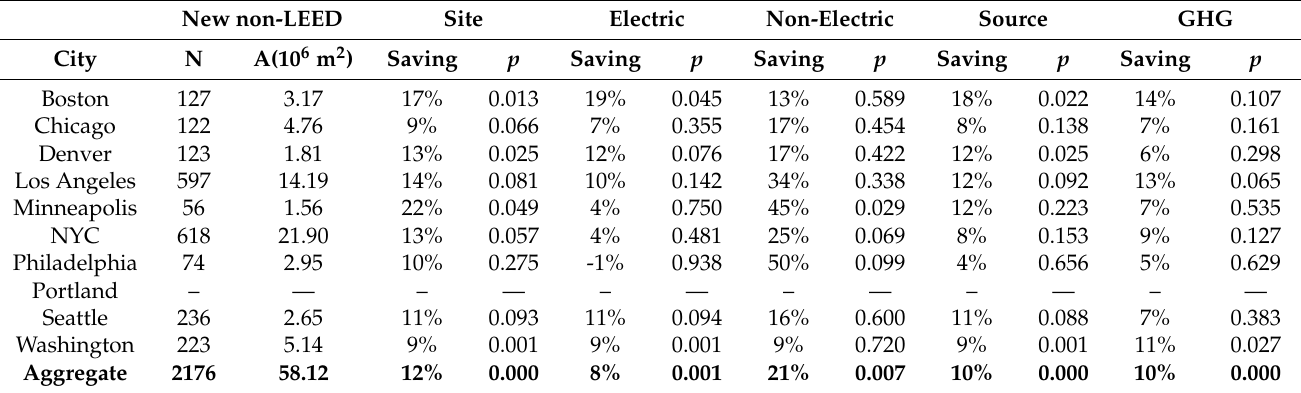
Table 6. LEED savings in the five intensity metrics relative to the area weighted means for newer, non-LEED offices in the same cities. N and A are for the subset of newer non-LEED offices whose mean year built matches that for LEED in the same city. The p -values are 2-sided, calculated using permutation testing with 10,000